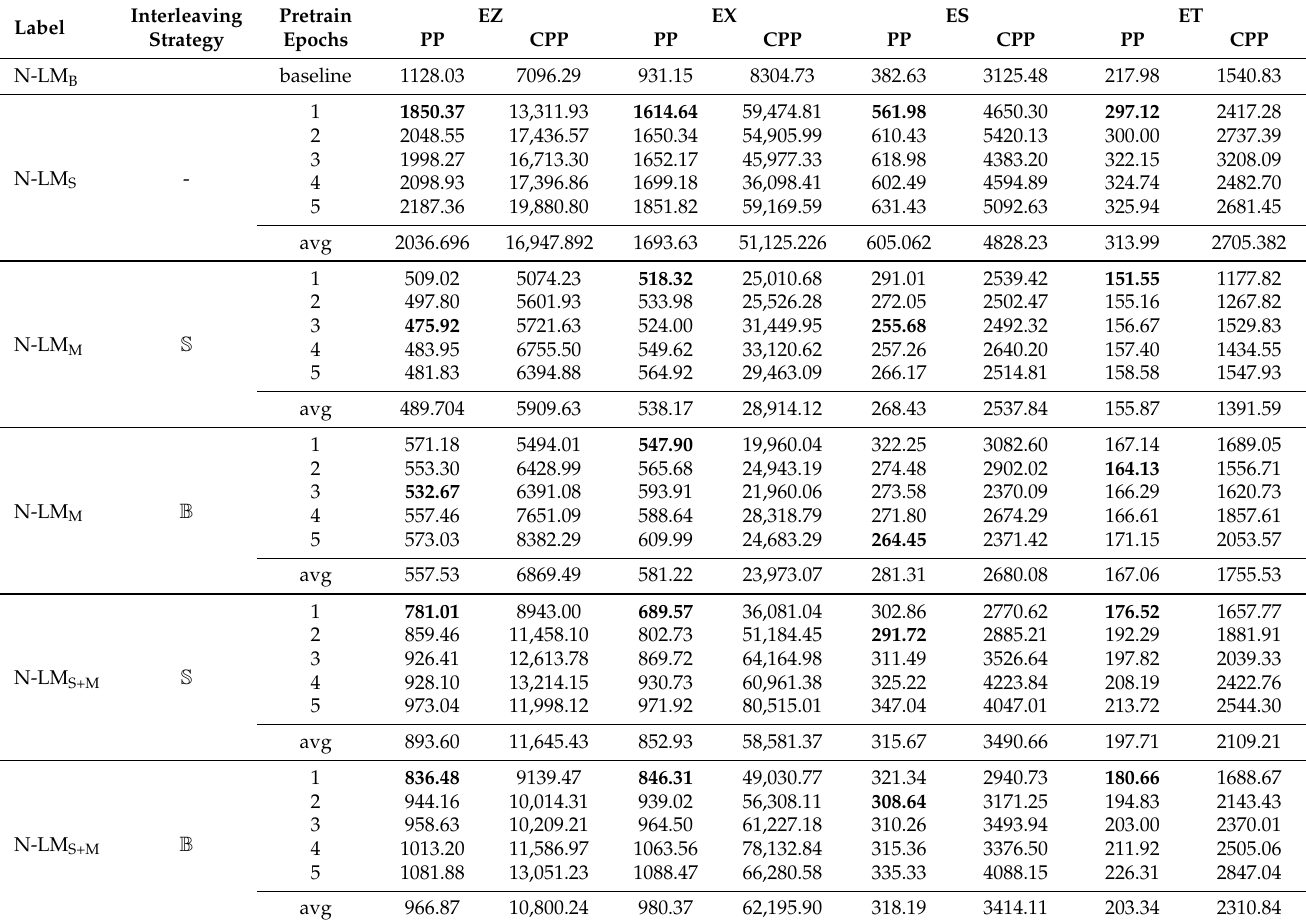
Table 5. Development set perplexity (PP) and perplexity over code-switches (CPP) during the optimisation of the pretraining strategy for each of the respective language pairs: English–isiZulu (EZ), English–isiXhosa (EX), English–Sesotho (ES), and English–Setswana (ET). The epoch which afforded the lowest development set perplexity across the different strategies is denoted in